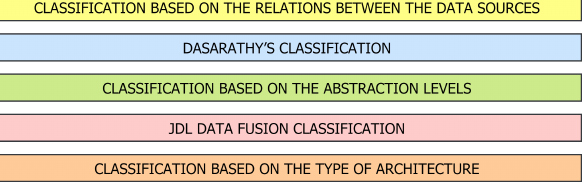
Figure 2. Various classifications of data aggregation